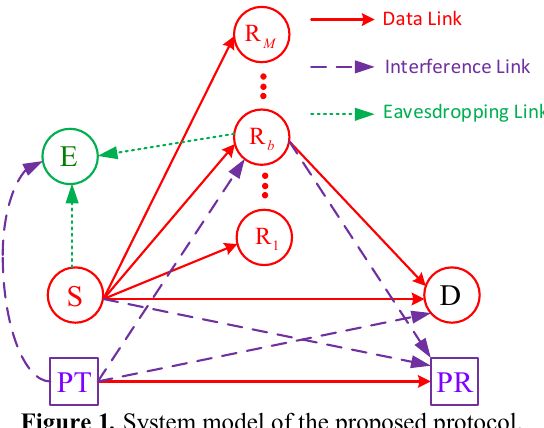
Figure 1 . System model of the proposed protocol. In Fig. 1, the system model of the proposed protocol is shown. In the primary network, a primary transmitter (PT) transmits its data to a primary receiver (PR). In the secondary network, a secondary source (S) attempts to transmit the data to a secondary destination (D) with help , where from M secondary relays denoted by R m 1,2,..., m M = . Also in the secondary network, an eavesdropper (E) tries to overhear the source data transmitted by the source and the relays. Assume that all the terminals are equipped with a single antenna and operate in half-duplex mode.